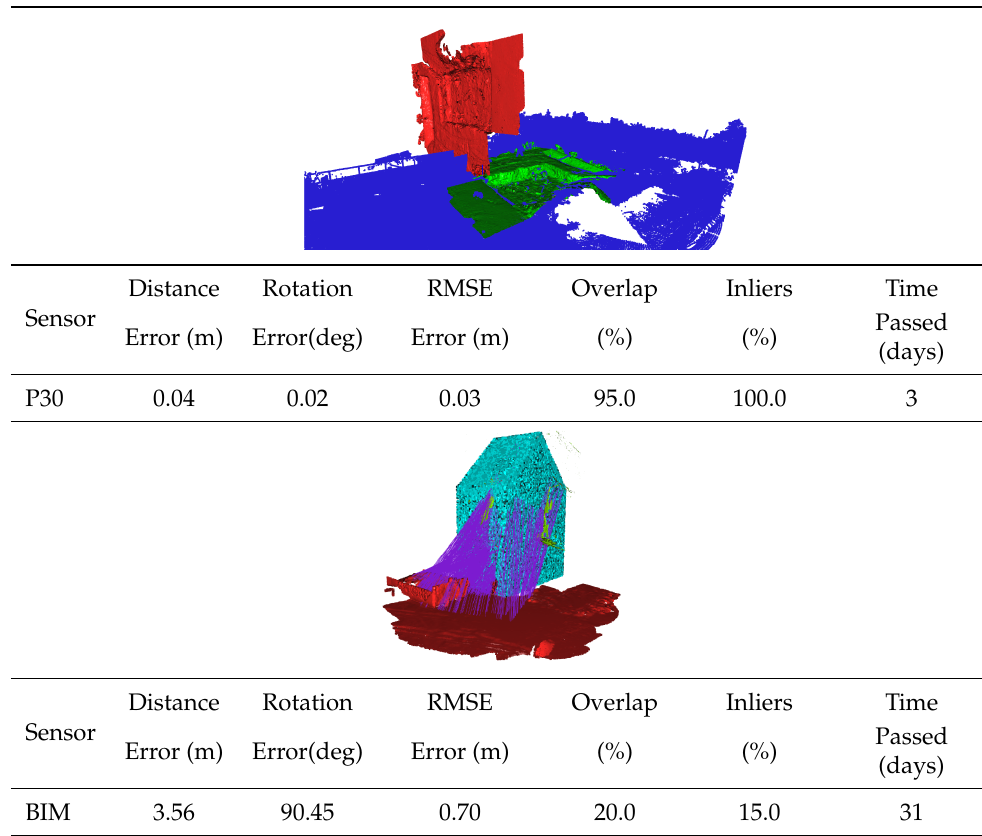
Table 7. Three-dimensional matching estimations based on FPFH feature